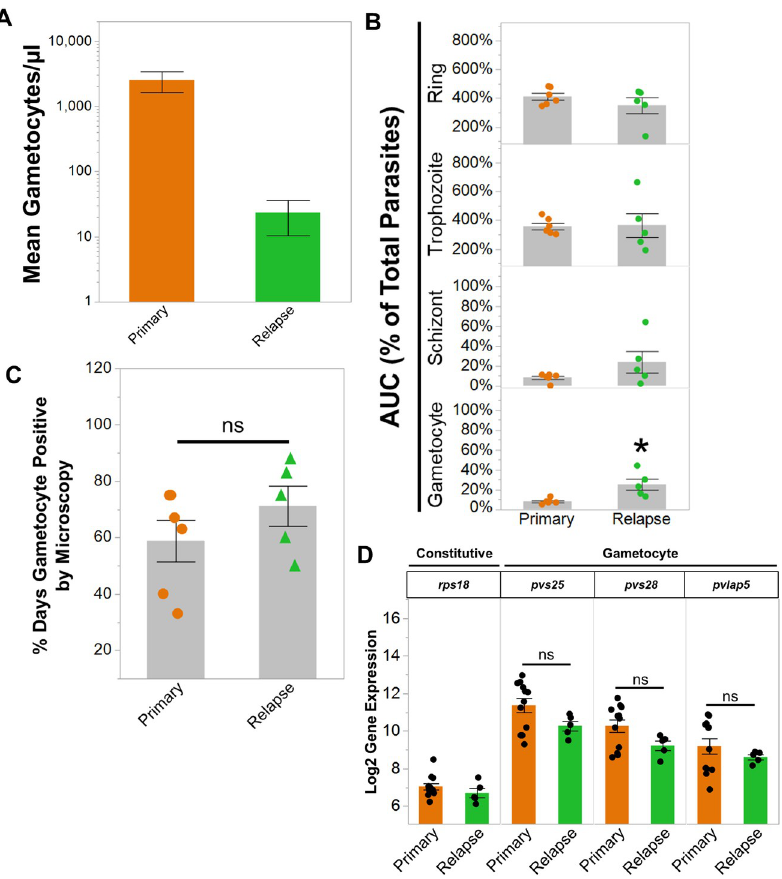
Fig 9. Clinically silent P . cynomolgi relapses harbor gametocytes. (a) Absolute number of gametocytes during primary and relapse infections as determined by microscopy. (b) The area under the curve of the proportions of rings, trophozoites, schizonts, and gametocytes during primary and relapse infections. The cumulative percent area exceeds 100% for rings and trophozoites because the infections were more than a single day. (c) The percentage of days out of the primary and relapse infections when gametocytes were observed by microscopy. (d) Gene expression of representative constitutive and gametocyte genes as determined by RNA-Seq during primary and relapse infections. All gametocyte genes are P . cynomolgi homologues of P . vivax genes implicated in transmission; the P . vivax gene annotation is listed for simplicity. Bars in all graphs indicate the mean log 2 gene expression of the data points shown or average percent of each stage; Error Bars = SEM. Statistical significance was assessed by a paired t-test. Asterisks indicate a p-value < 0.05; ns = not